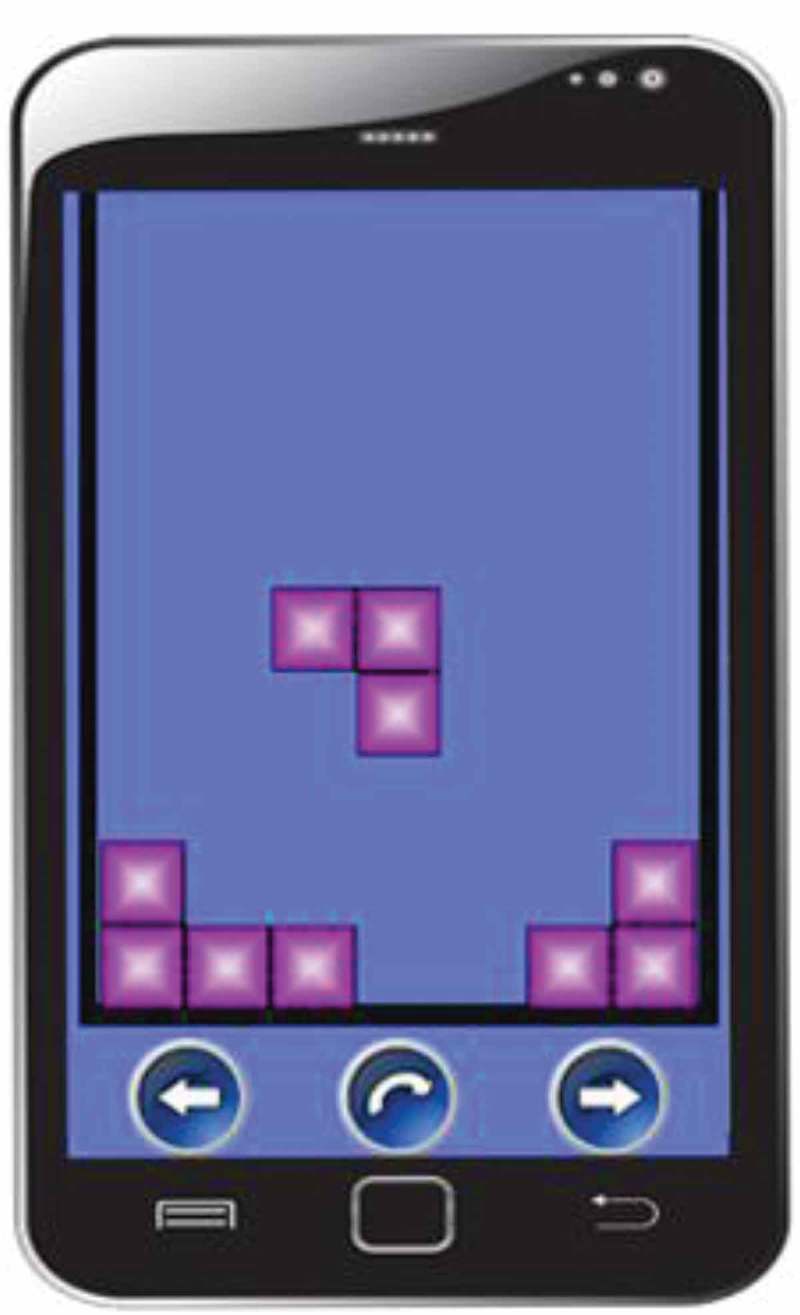
Screenshot of TGP2.